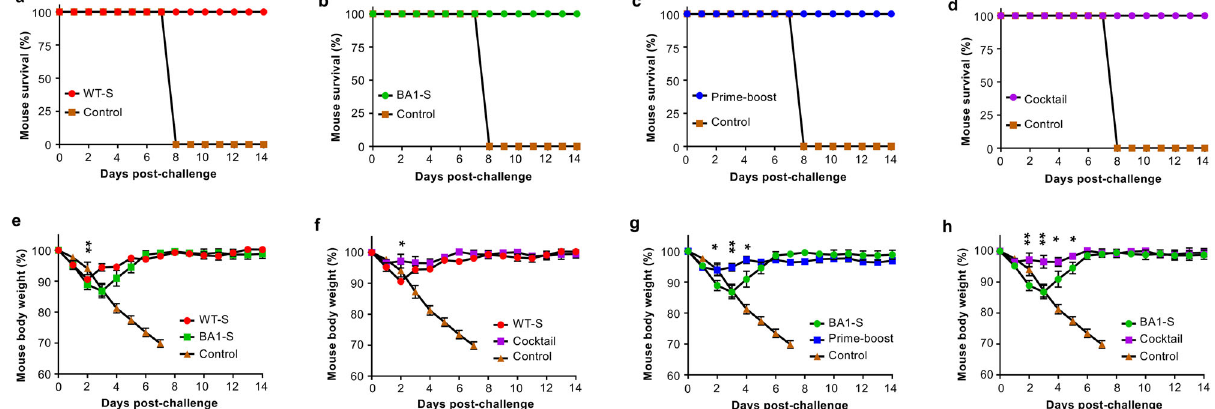
Fig. 4 Cocktail or prime-boost of SARS-CoV-2 WT-S and BA1-S proteins completely protected mice from the lethal Delta variant challenge. Above immunized K18-hACE2-Tg mice or control mice injected with PBS plus adjuvants were challenged with the SARS-CoV-2 Delta variant (10,000 PFU/mouse) 30 days after the last immunization, and observed for survival ( a – d ) and body weight changes ( e – h ) for a period of 14 days after challenge. The data (in e – h ) are expressed as mean ± s.e.m of fi ve mice in each group. Statistical signi fi cance among different vaccination groups was analyzed using Ordinary one-way ANOVA. * ( P < 0.05) and ** ( P < 0.01) indicate signi fi cant differences between the WT-S and BA1-S ( e ), WT-S and WT-S/BA1-S cocktail ( f ), BA1-S and WT-S prime/BA1-S boost ( g ), as well as BA1-S and WT-S/BA1-S cocktail ( h )